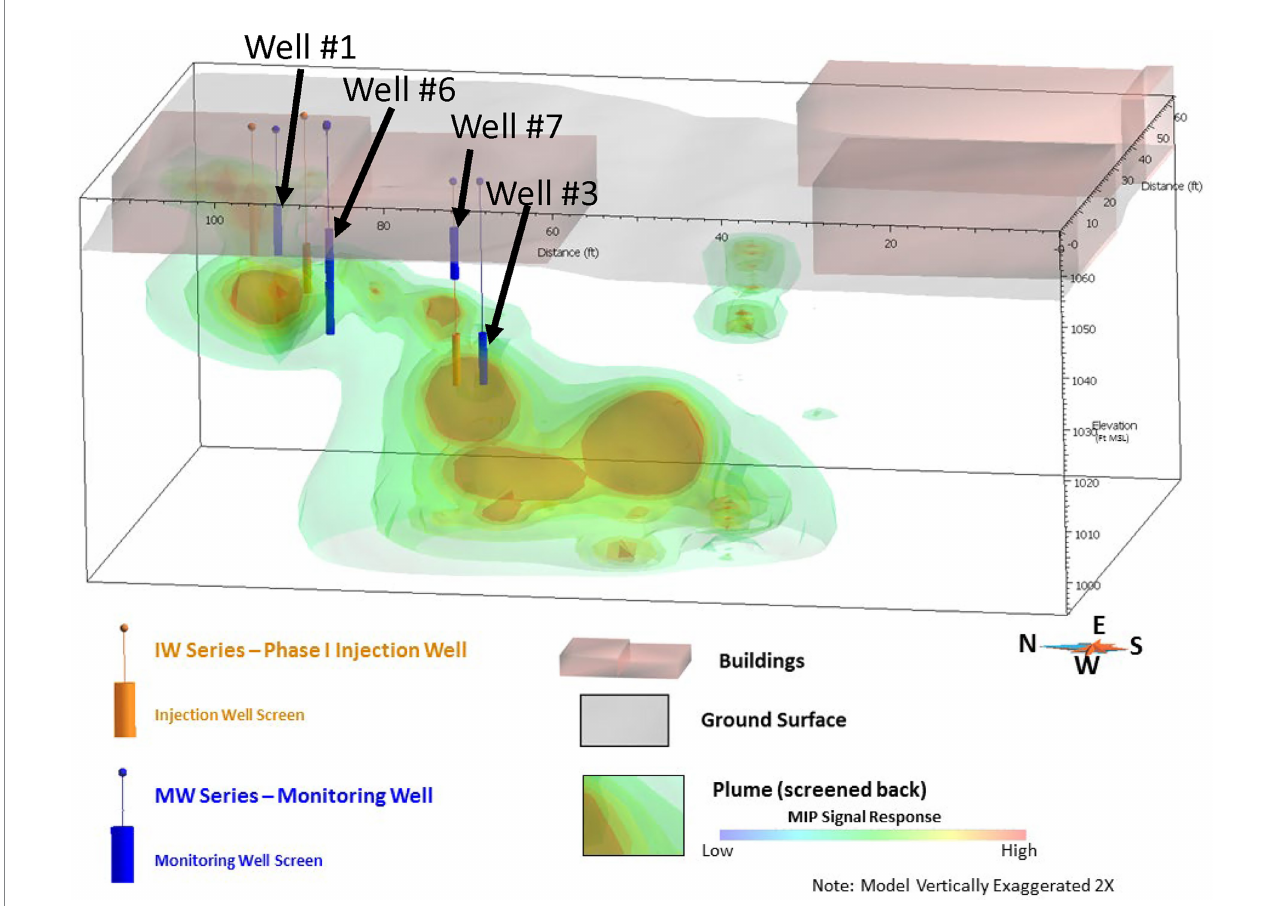
FIGURE 1 Site 1 TCE plume configuration based on MIP results. Pilot study injection wells are shown in orange and pilot study performance monitoring wells are shown in blue.